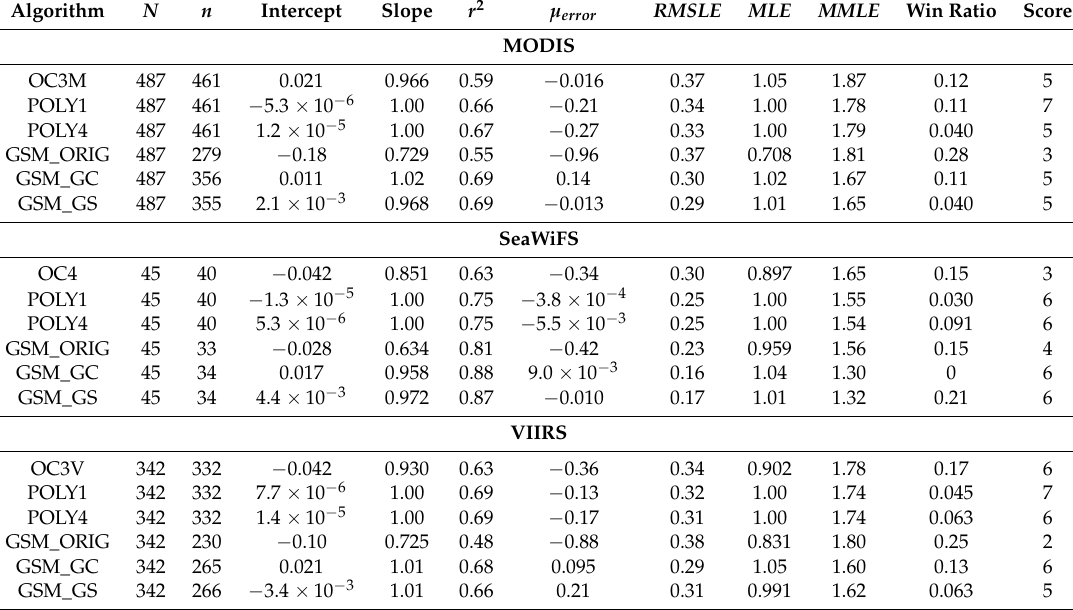
Table 4. Same as Table 3, for the